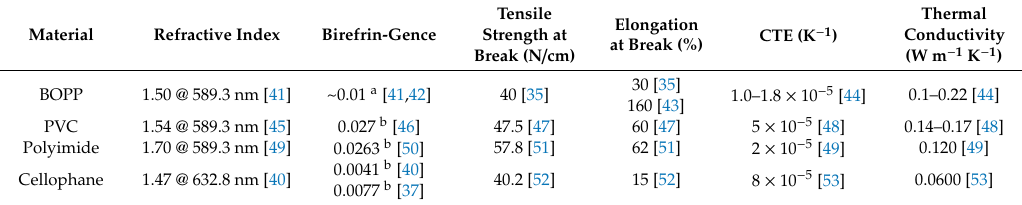
Table 1. Indicative values of optical, mechanical and thermal parameters of typical polymeric backing materials used in transparent pressure sensitive adhesive tapes. BOPP = biaxially oriented polypropylene; PVC = polyvinyl chloride; CTE = coe ffi cient of thermal expansion.